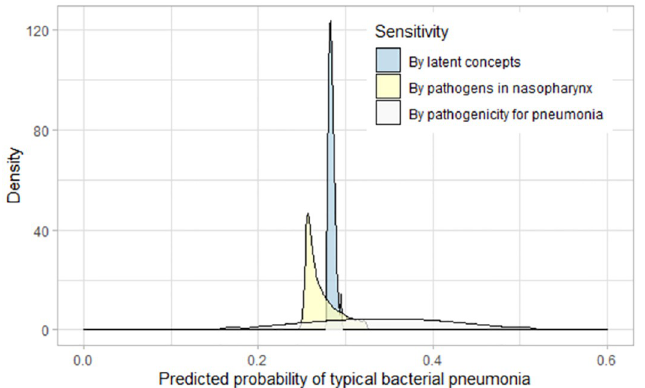
Fig 8. Sensitivity analysis, BN v4.5. Relevant parameters were varied by 20% to investigate how they affected the predicted probability of involvement of typical bacteria. This target prediction was most sensitive to the pathogenicity of potential pathogens in causing pneumonia (white), followed by the prevalence of various pathogens in nasopharynx (yellow), and was least sensitive to the latent epidemiological concepts (blue). CPTs that were varied in the pathogenicity group include those for both viral-like pneumonia (23) and typical bacterial pneumonia (24) . The pathogens in nasopharynx group involve CPTs for RSV in nasopharynx (16) , Influenza in nasopharynx (15) , HMPV in nasopharynx (17) , Parainfluenza in nasopharynx (18) , Mycoplasma in nasopharynx (19) and bacteria in nasopharynx (20) . And the latent concepts group involved CPTs for level of exposure (12) , susceptibility to colonisation (13) and susceptibility to progression (14)